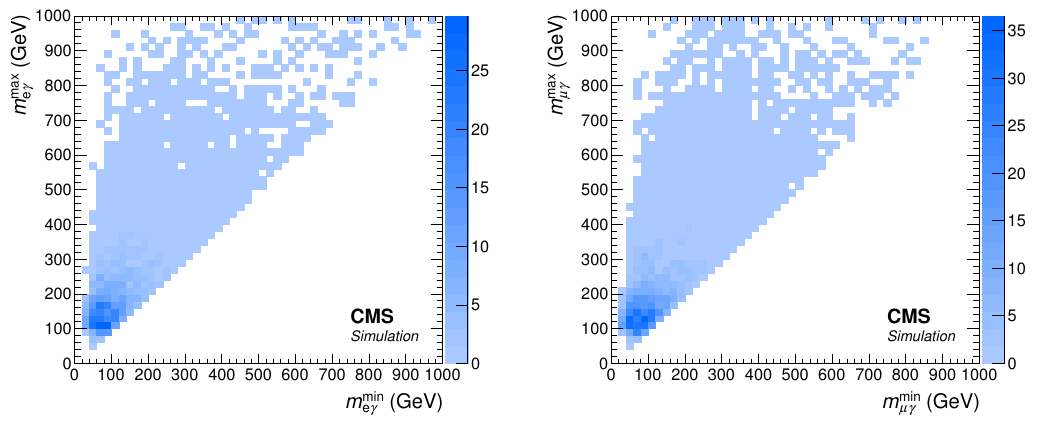
Figure 3 . The two-dimensional distributions of m max of 500 GeV (left) and of excited muons with a mass of 750 GeV (right), after the event selection, normalized to the expected signal cross section at (cid:3) = 10 TeV. The red dashed lines denote the boundary of the L-shaped search window.